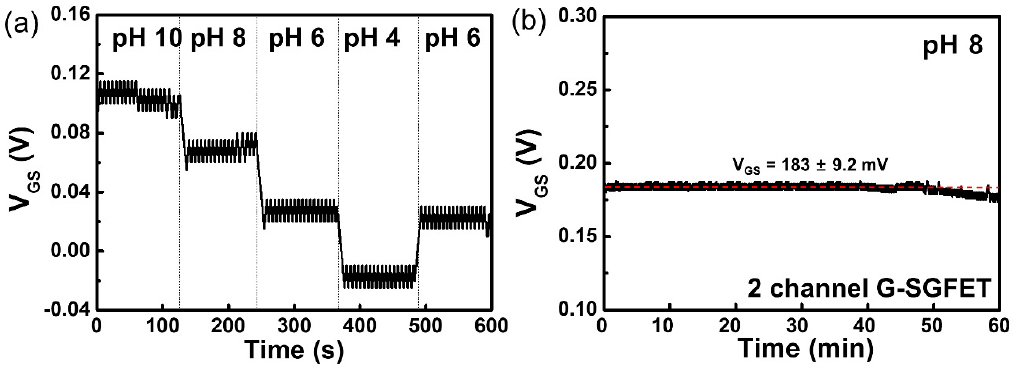
Figure 6. ( a ) Real-time detection of pH in electrolyte solution using two-channel G-SGFET. ( b ) The long-term stability of two-channel G-SGFET in a buffer solution of pH